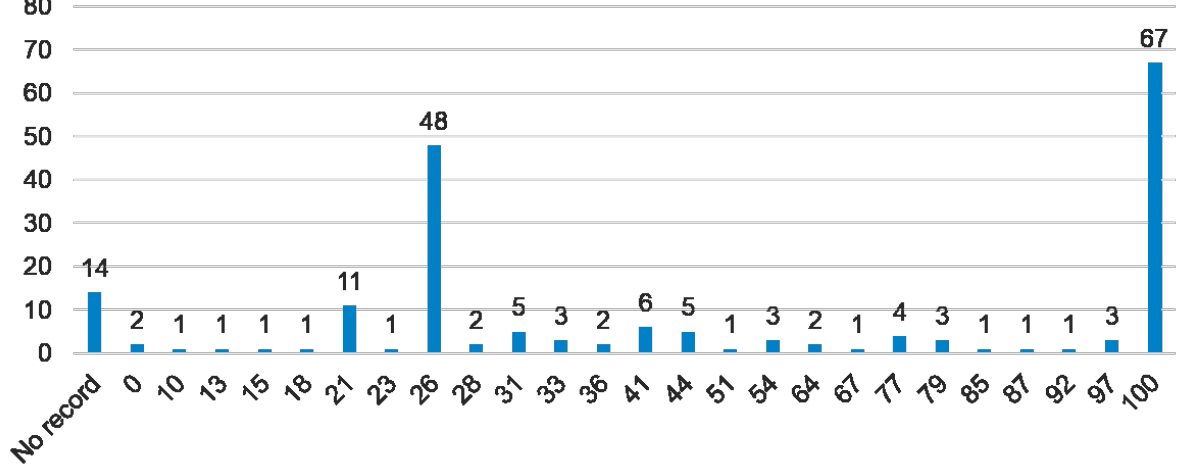
Figure 3. Cognitive behavioral therapy program completion at the time of the